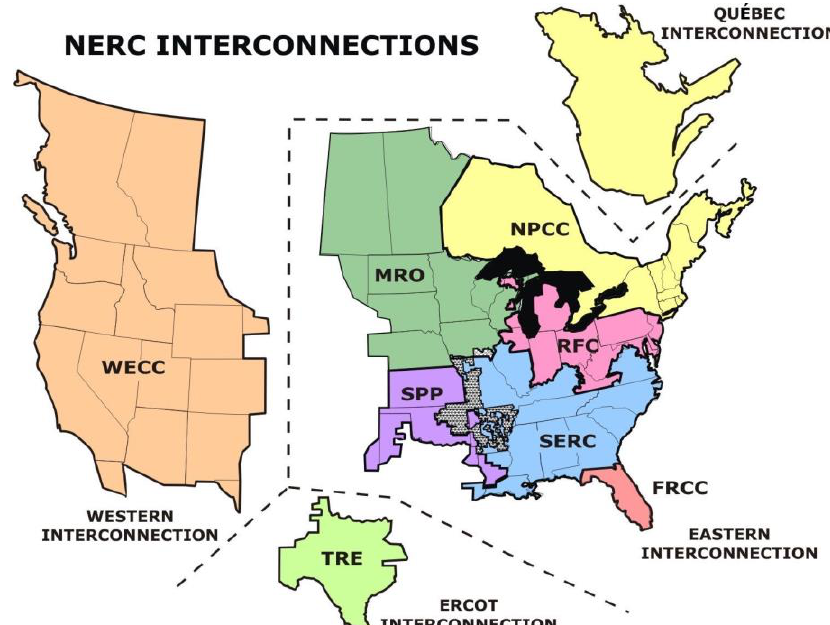
Figure 4. North American Electric Reliability Council (NERC) Interconnections (Source: http://www.nerc.com/AboutNERC/keyplayers/Documents/NERC_Interconnections_Color_072512.jpg accessed 24 August